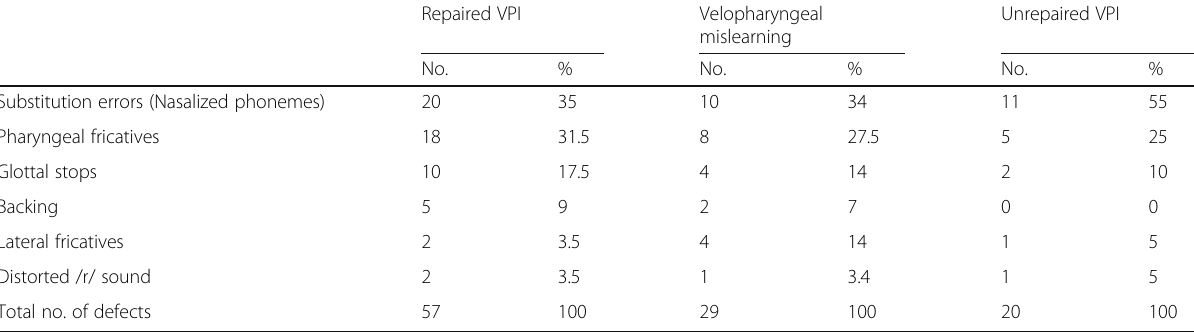
Table 1: Frequency of each articulatory error in each group